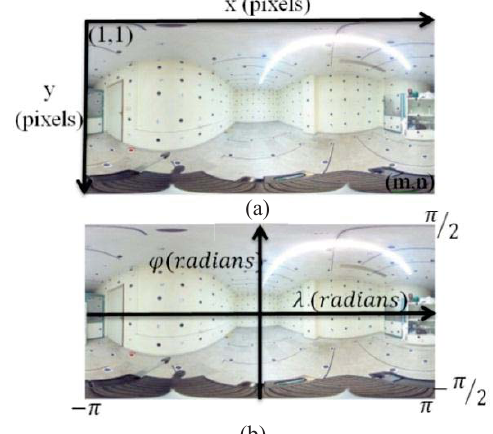
Image coordinates (x, y) are moved to spherical coordinate system by equirectangular projection (Equations 6 and 7). Both coordinate systems are represented in Figure 3.